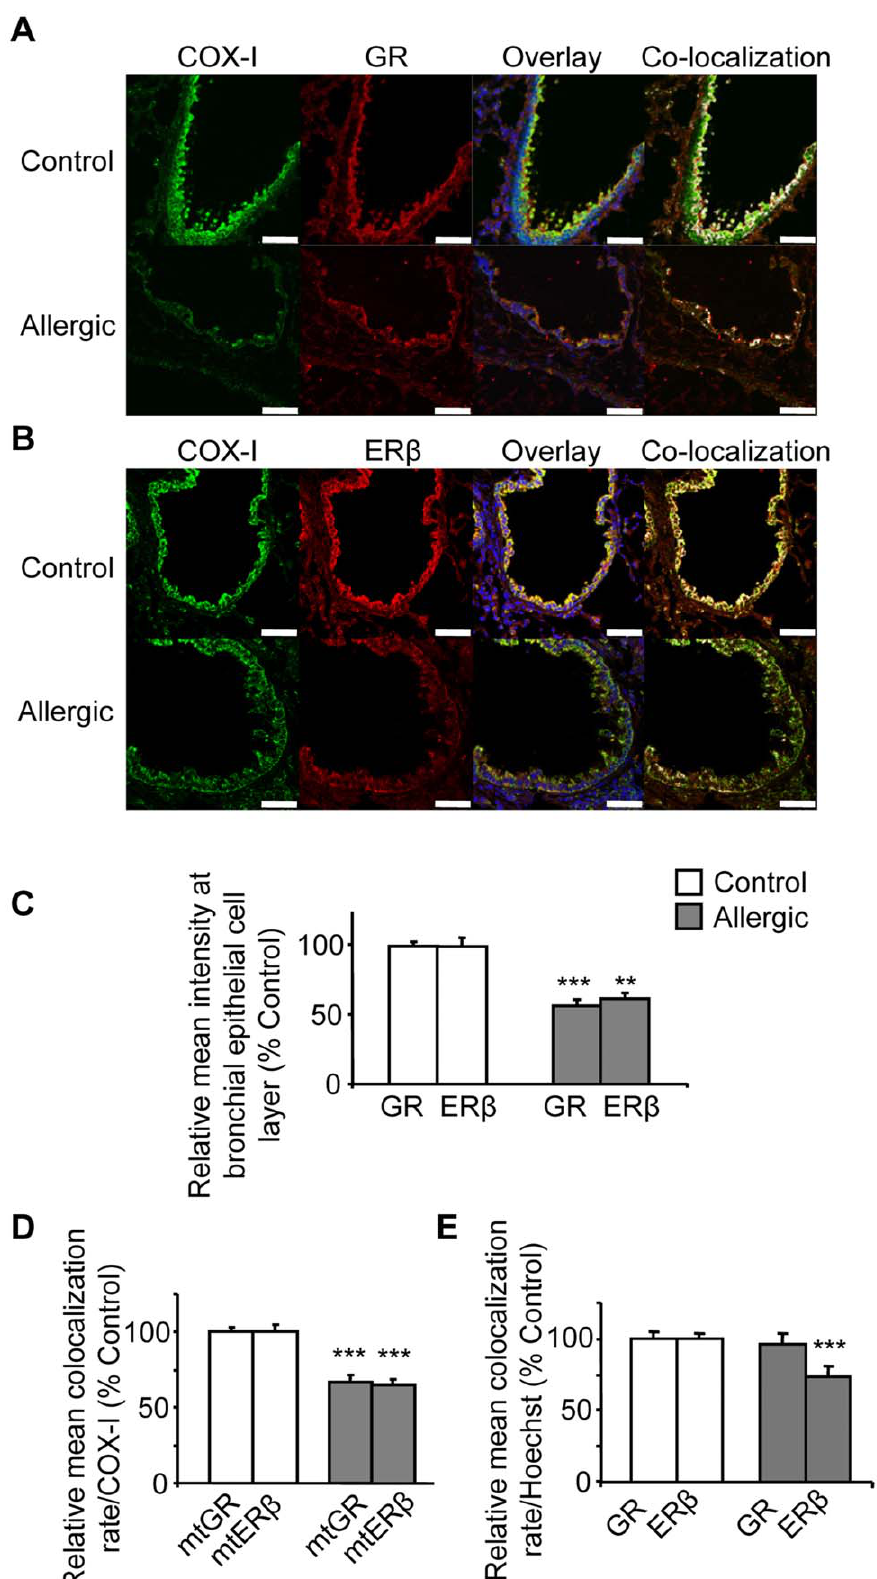
Figure 4. Allergic airway inflammation reduces mtGR, mtER and nuclear ER in mice lung epithelial cell layer. Confocal immunofluorescence images of control and allergic mice lung sections immunostained for COX-I (green), GR (red), ER b (red) and Hoeschst (nuclear fluorescence stain, blue) were obtained and analysed using Leica Las-AF image system. (A) Representative images of COX-I staining, GR staining,